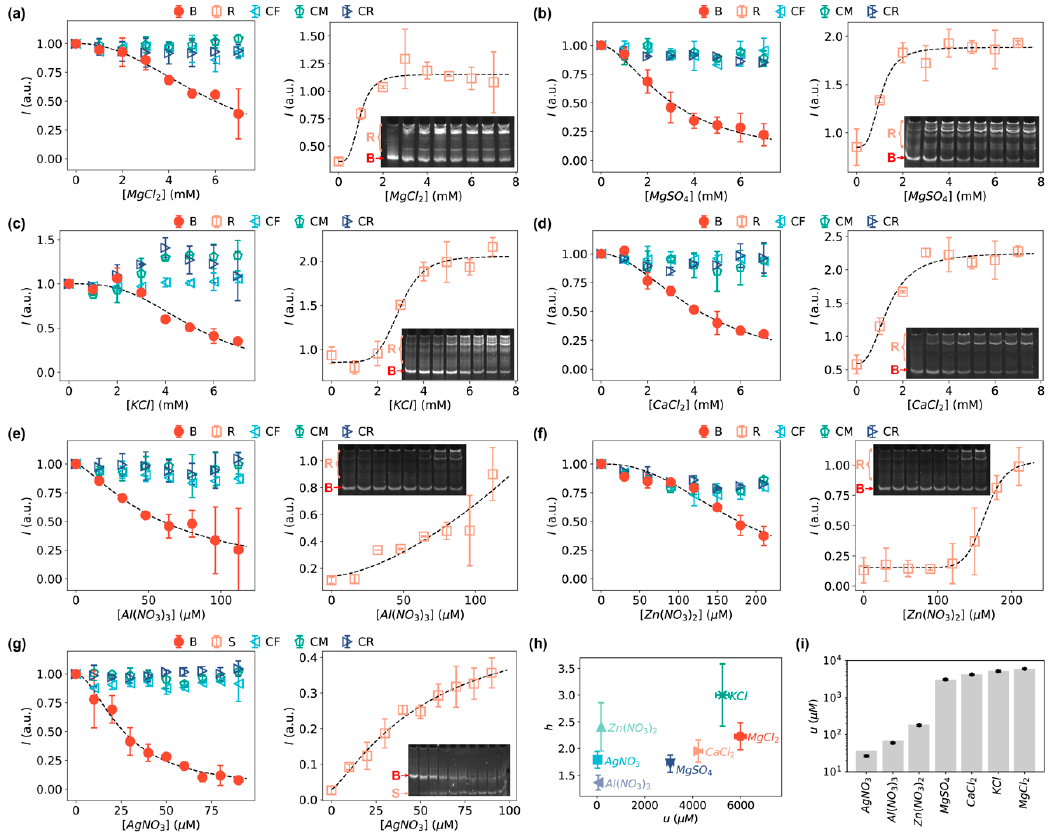
Figure 3. Intensities of the bands of DNA bows (red circles), relaxed DNA loops (orange squares), and linear DNA controls (cyan triangles, green pentagons, blue triangles) in the presence of various salts at increasing concentrations: ( a ) MgCl 2 , ( b ) MgSO 4 , ( c ) KCl, ( d ) CaCl 2 , ( e ) Al(NO 3 ) 3 , ( f ) Zn(NO 3 ) 2 and ( g ) AgNO 3 (the orange squares for AgNO 3 are for the dissociated single strands S). Insets are the representative, cropped gels of bent DNA bows in the presence of the corresponding salts at increasing concentrations. B and R (or S) indicate the bands used for quantification of the intensities. The corresponding full-length gels are shown in Figure S1. Error bars in panels a–g represent the standard deviation from 2–4 replicates. ( h ) Fitted ℎ and 𝑢 values from the modified Hill equation for the inorganic salts. ( i ) Fitted 𝑢 -values for quantifying the strength of DNA interactions with inorganic salts.